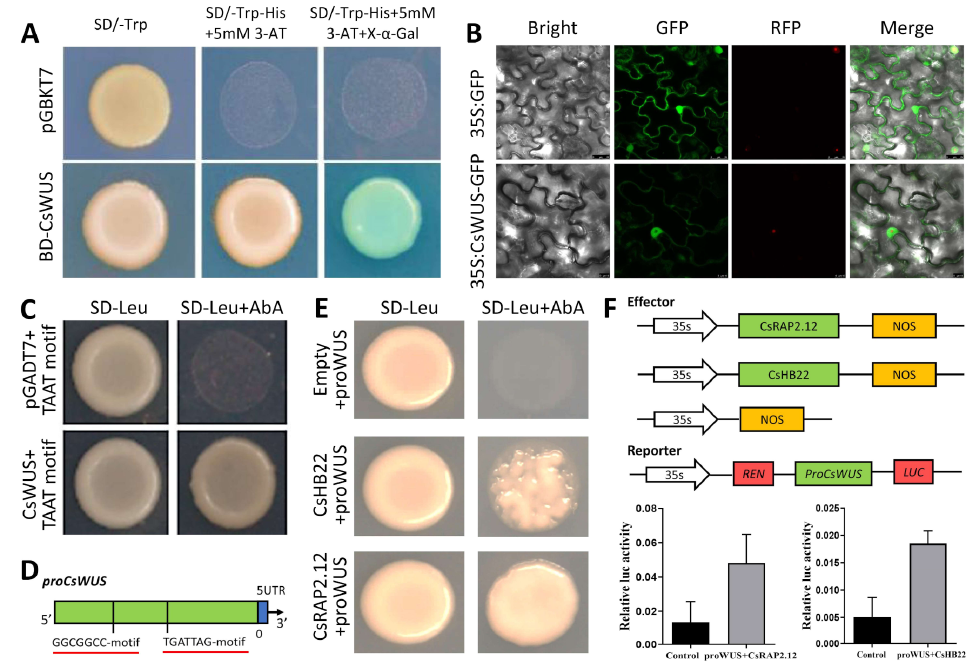
Figure 7. Functional analysis of CsWUS . ( A )Transcriptional activation of CsWUS ; full-length CsWUS fused with GAL4 DNA-binding domain then expressed in yeast strain AH109. Transformed yeast cells were dropped and deposited on selective media (SD/-Trp-His-Ade-Leu) supplemented with 3AT+x-a-gal, with negative control empty pGBKT7 vector. ( B ) Subcellular localization in tobacco cells; GFP:CsWUS was transiently expressed in tobacco cells under CaMV 35s promoter. Scale bar = 25 µ m. ( C ) TAAT motif binding confirmation followed by yeast one-hybrid method, pGADT7 used as a negative control, TAAT+AD-CsWUS and pGADT7 was grown on SD/-Leu supplemented with Aureobasidin A [53]. ( D ) Schematic diagram of proCsWUS and construct of yeast one-hybrid assay. ( E ) Interacting TFs identified based on yeast one-hybrid library screening; positive transformations were determined by spotting dilution of yeast onto SD/ − Leu supplemented with AbA, negative control (promoter+PGADT7). ( F ) Transient expression assay. Schematic diagram of reporter and effector constructs used for transient expression assays; co-expression of CsRAP2.12 and CsHB22 , CsWUS promoter contained GCC- and